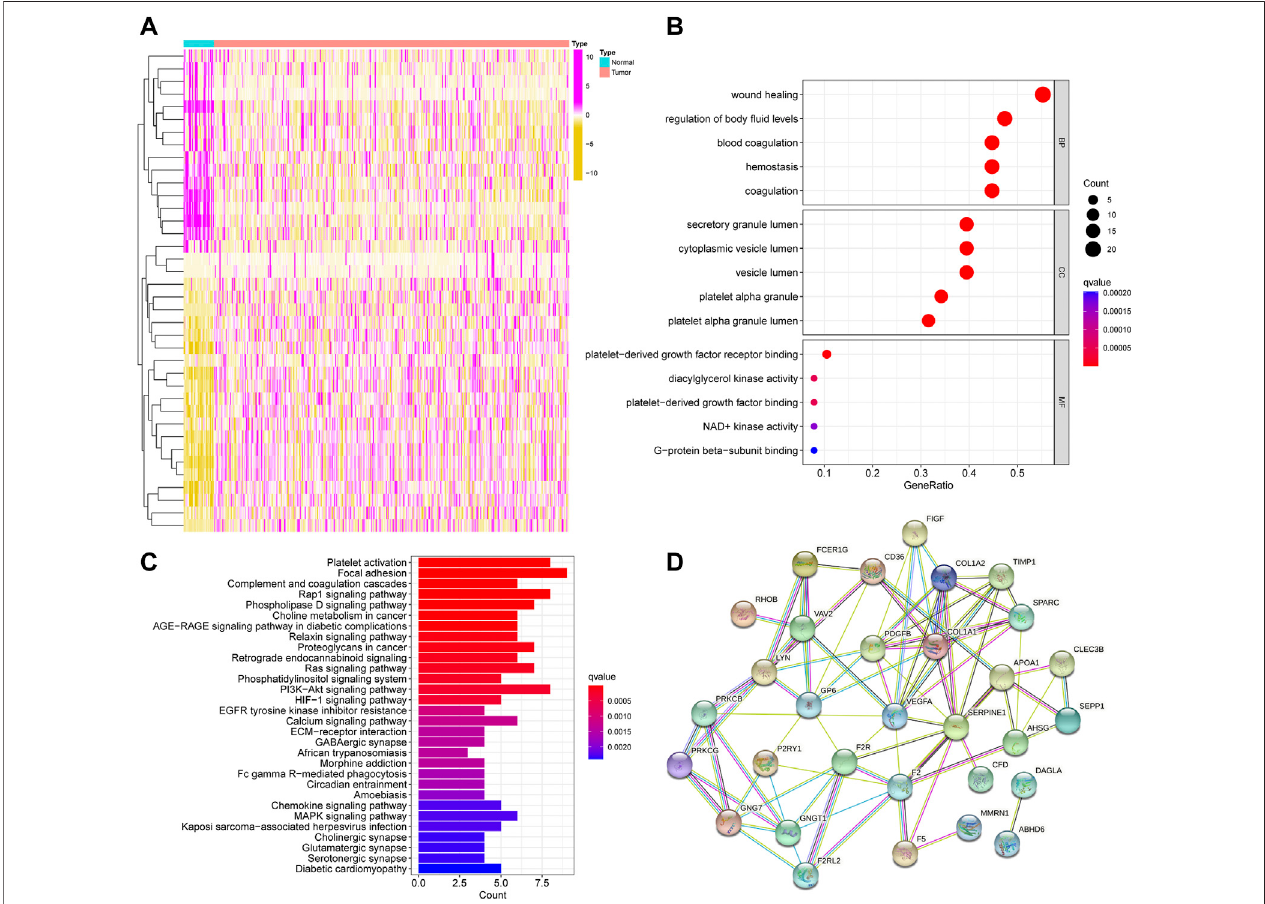
FIGURE2| Identi fi cation andfunctionalenrichmentanalysisofDEPFRGsinTCGAcohort. (A) Theheatmapof38DEPFRGsinGCand normaltissues. (B) TheGO enrichment analysis. (C) The KEGG pathway analysis. (D) The PPI network was constructed through 38 DEPFRGs. The interaction score was set to 0.4. DEPFRGs, differentially expressed platelet function-related genes; GC, Gastric cancer; GO, Gene Ontology; KEGG, Kyoto Encyclopedia of Genes and Genomes; PPI, protein- protein interaction. * p < 0.05, ** p < 0.01, *** p < 0.001.